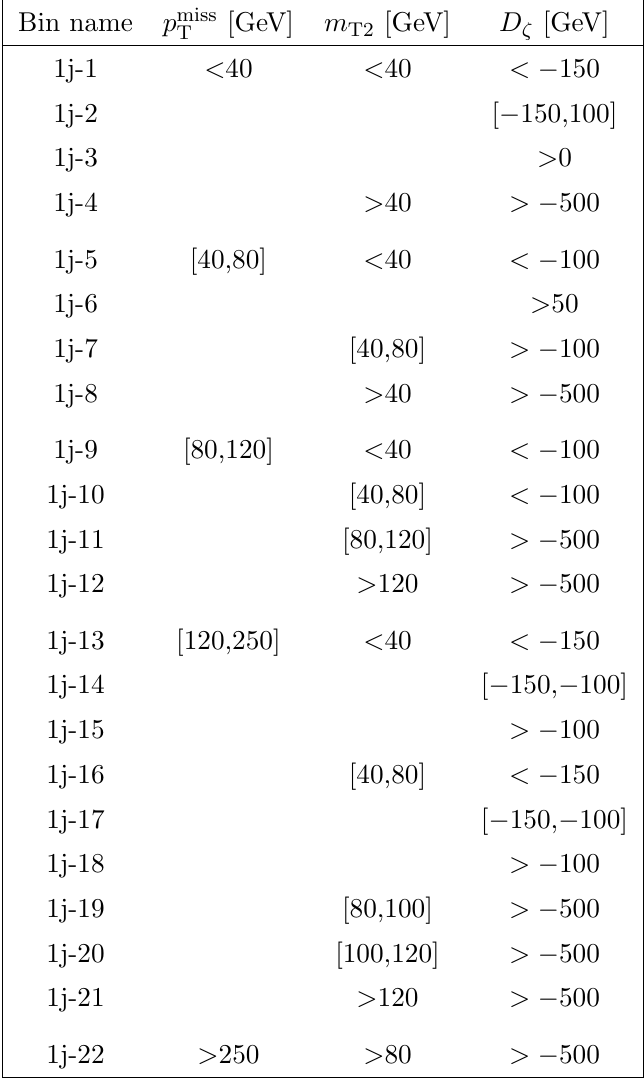
Table 7. De(cid:12)nition of SRs in the 1-jet category for the e (cid:22) (cid:12)nal